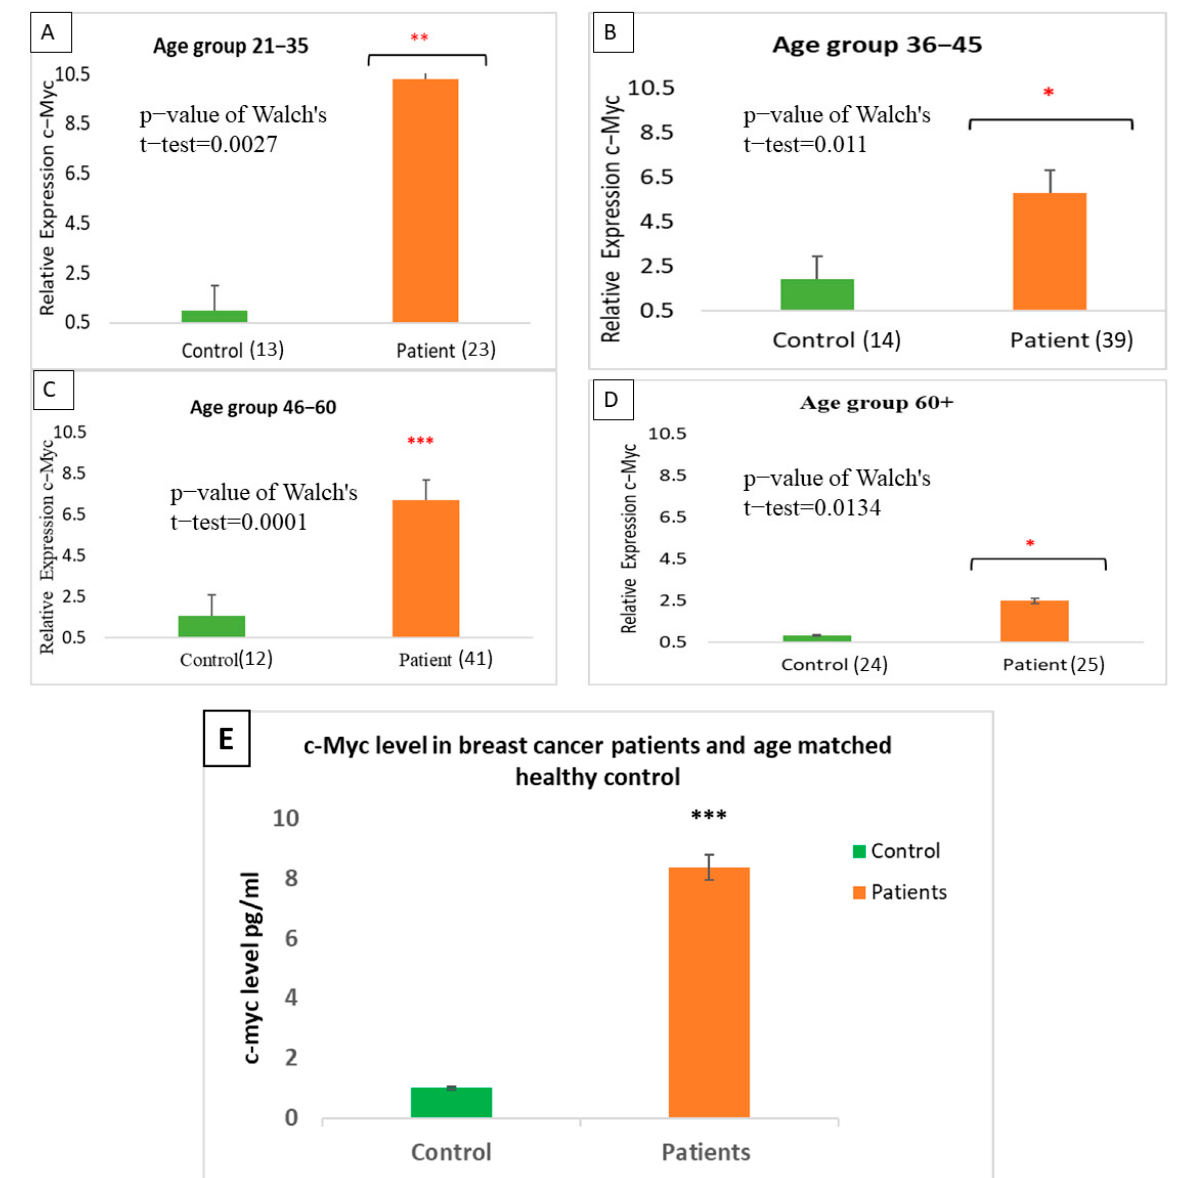
Figure 4. ( A – E ) Comparison of mean Relative Expression (RE = 2 ∆∆ Ct ) of c-myc in breast cancer patients and healthy controls (RE calculated using Livak method from two-fold Ct values). Error bars indicate standard deviation. Asterisks indicate a significant difference determined using Welch’s t -test (* p > 0.05). ( A ) RE of age group 21 to 35 years patients n = 13, SEM = 4.1, (Average 2 ∆∆ Ct = 10.32) and healthy control (Average 2 ∆∆ Ct = 0.99). n = 23, SD = 0.1, Sqt of sample size = 4.8, SEM = 0.01, df = 1, p -value = 0.0027. ( B ) 2 ∆∆ Ct of age group 36 to 45 years. patients (Average 2 ∆∆ Ct = 5.81) and healthy control (Average 2 ∆∆ Ct = 1.95). n = 39, SD = 3.6, Sqt of sample size = 6.2, SEM = 1.5, df = 1, p -value = 0.01. ( C ) 2 ∆∆ Ct of age group 46 to 60 years patients (Average RE = 7.2) and healthy control (Average RE = 0.36). n = 41, SD = 0.48, Sqt of sample size = 3.46, SEM = 0.14, df = 1, p -value < 0.0001.